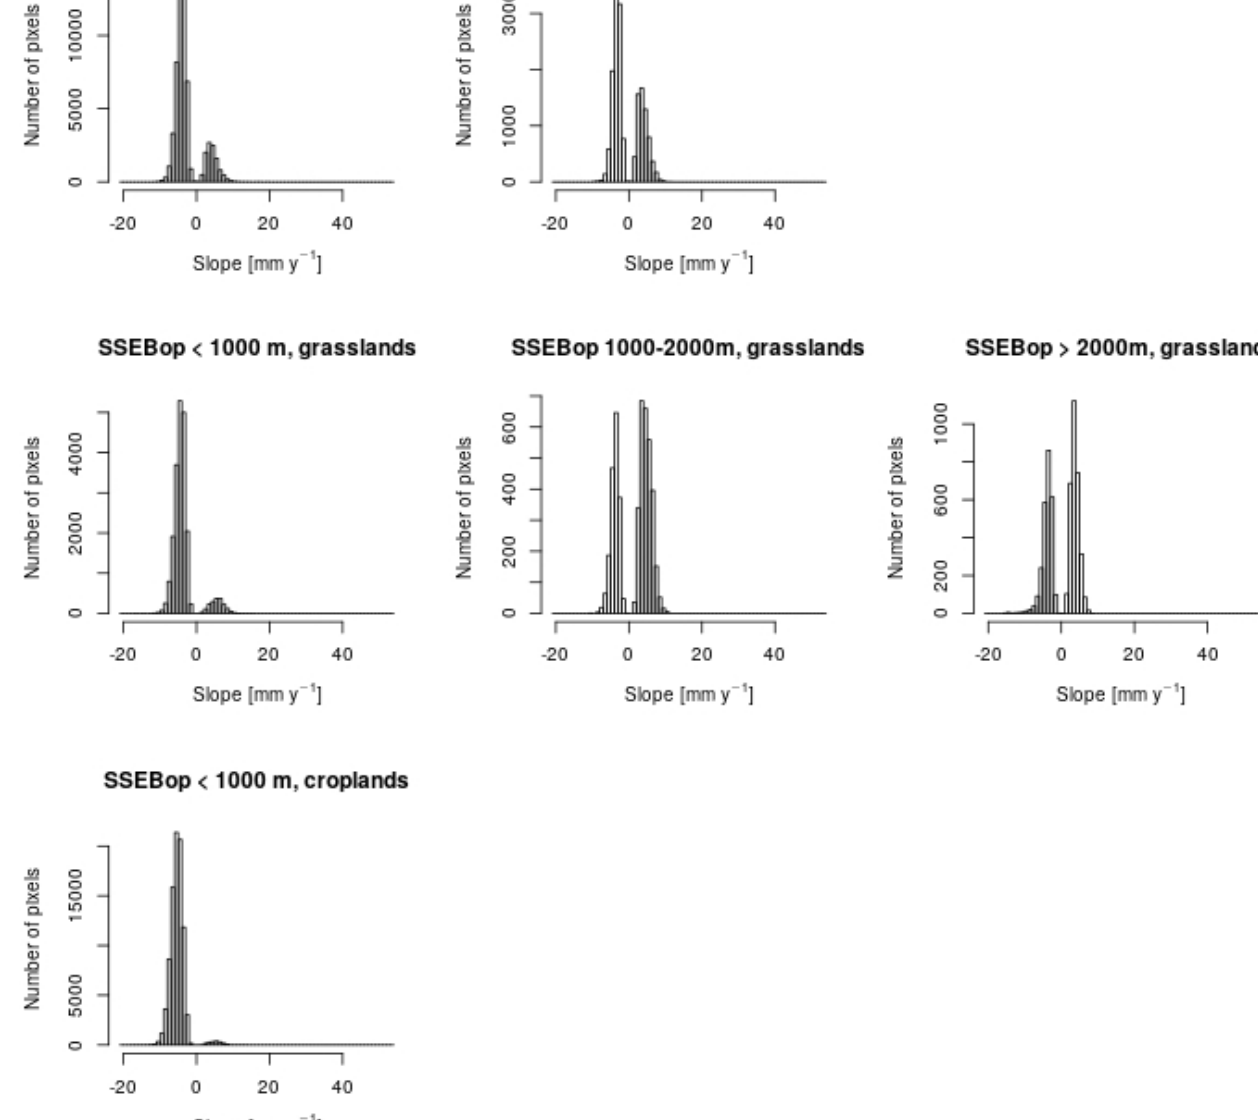
Table 5. Percentage of the area of the Alps with positive and negative slope of the trend (at 5% significance level) in monthly ET for MOD16 and SSEBop, in monthly PET, and in monthly tp .